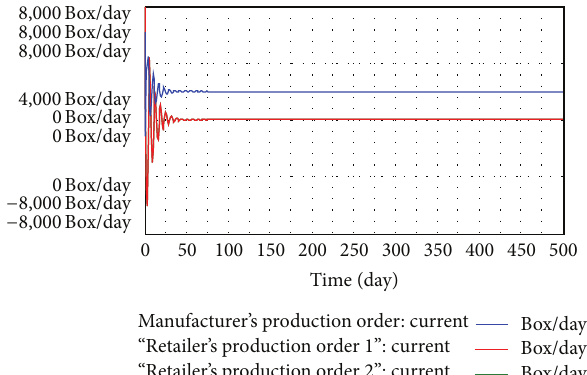
Figure 12: Changes of the order quantity of each member when parts recycling delay time is 14.